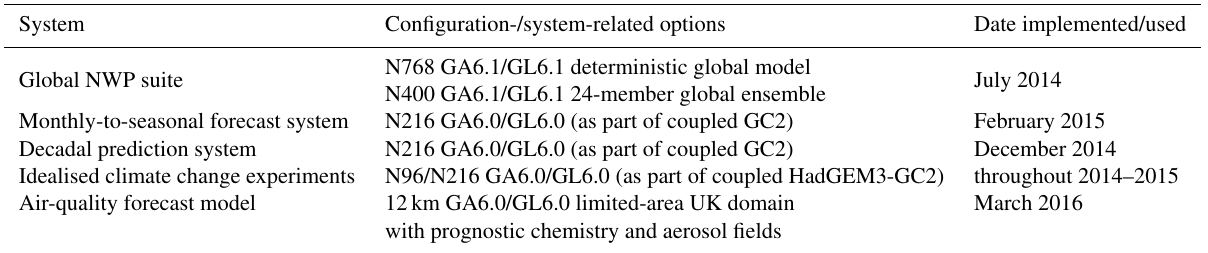
Table 5. A sample of Met Office operational prediction systems that have implemented configurations based on GA6 and the date of their implementation.